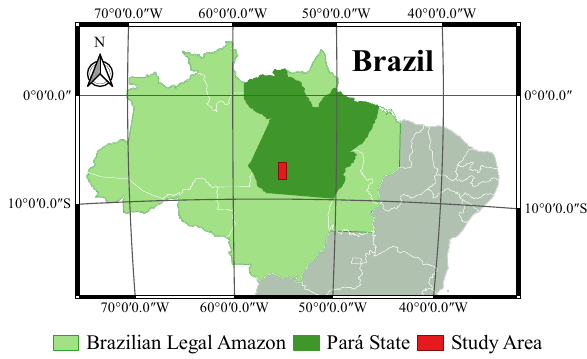
Figure 3. Geographical localization of the study area.